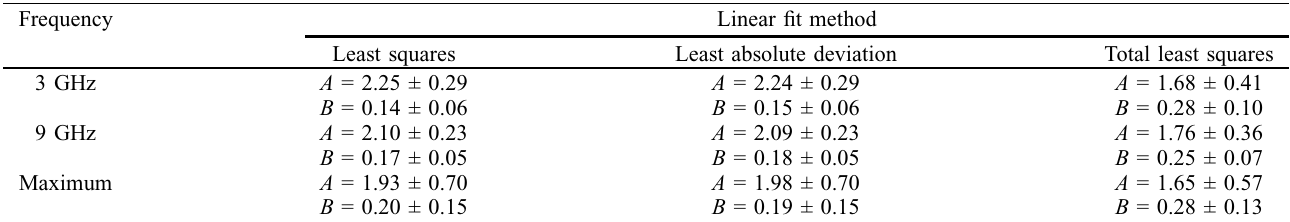
Table 2. Parameters of equation (1) using three different methods of linear fit.